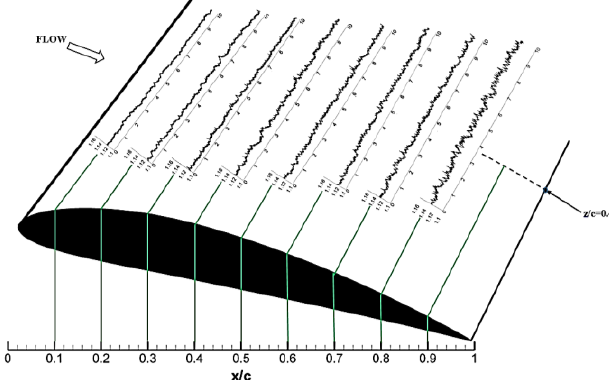
Fig. 6. Time-dependent voltage variance results of hot-film sensor